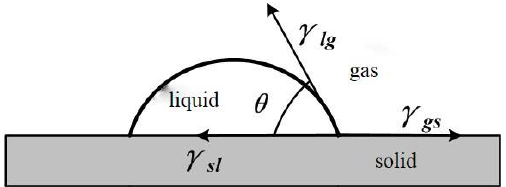
Figure 5. Schematic illustration of the contact angle of the liquid droplet on the surface.